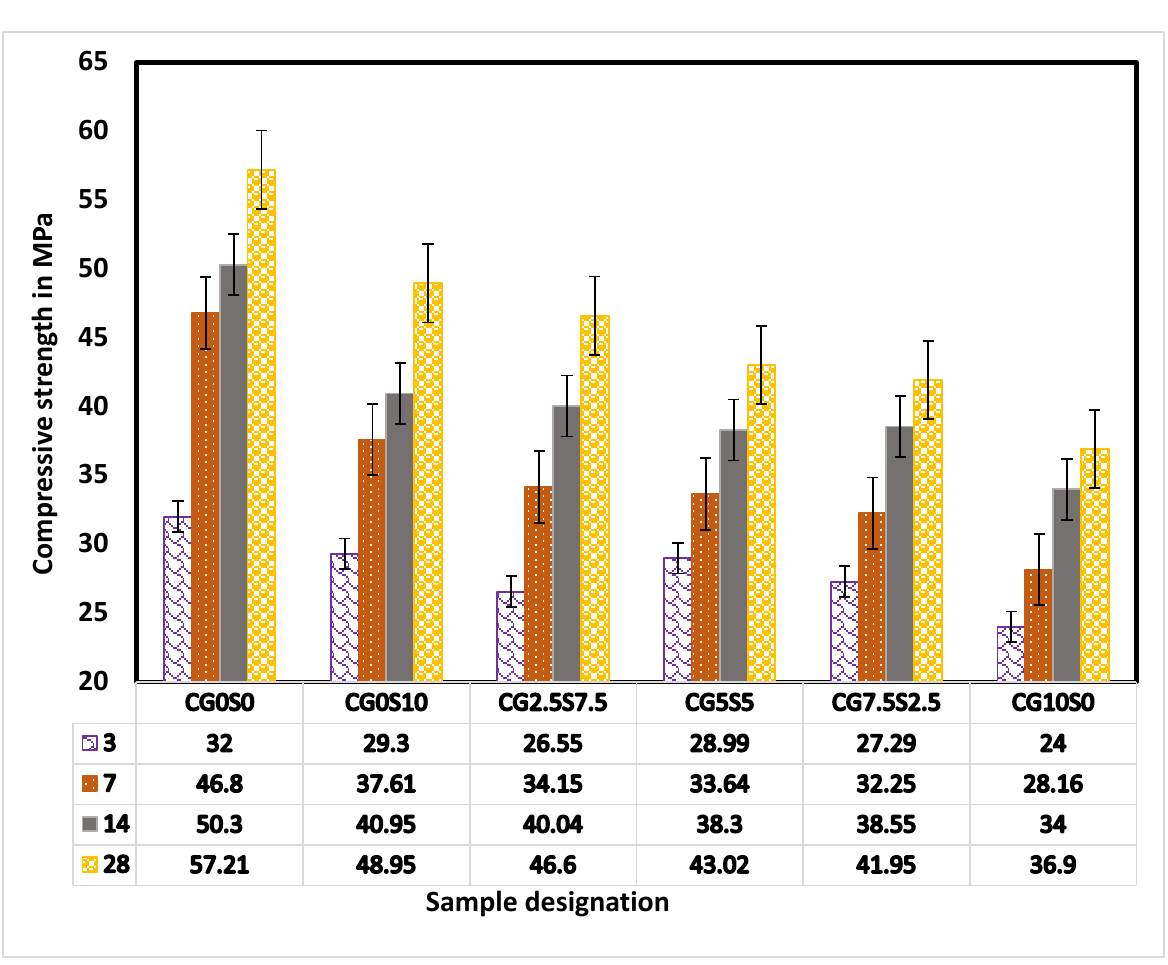
Figure 8. Concrete compressive strength and synergistic effect of silica fume and glass powder.